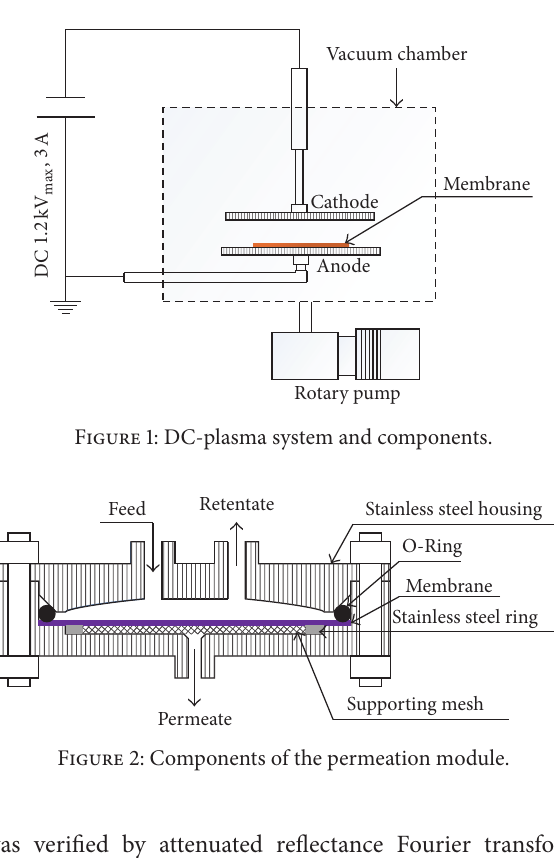
was verified by attenuated reflectance Fourier transform infrared (ATR-FTIR) spectroscopy in the range of 400– 4,000 cm −1 for the wave number with a resolution of 4 cm −1 .